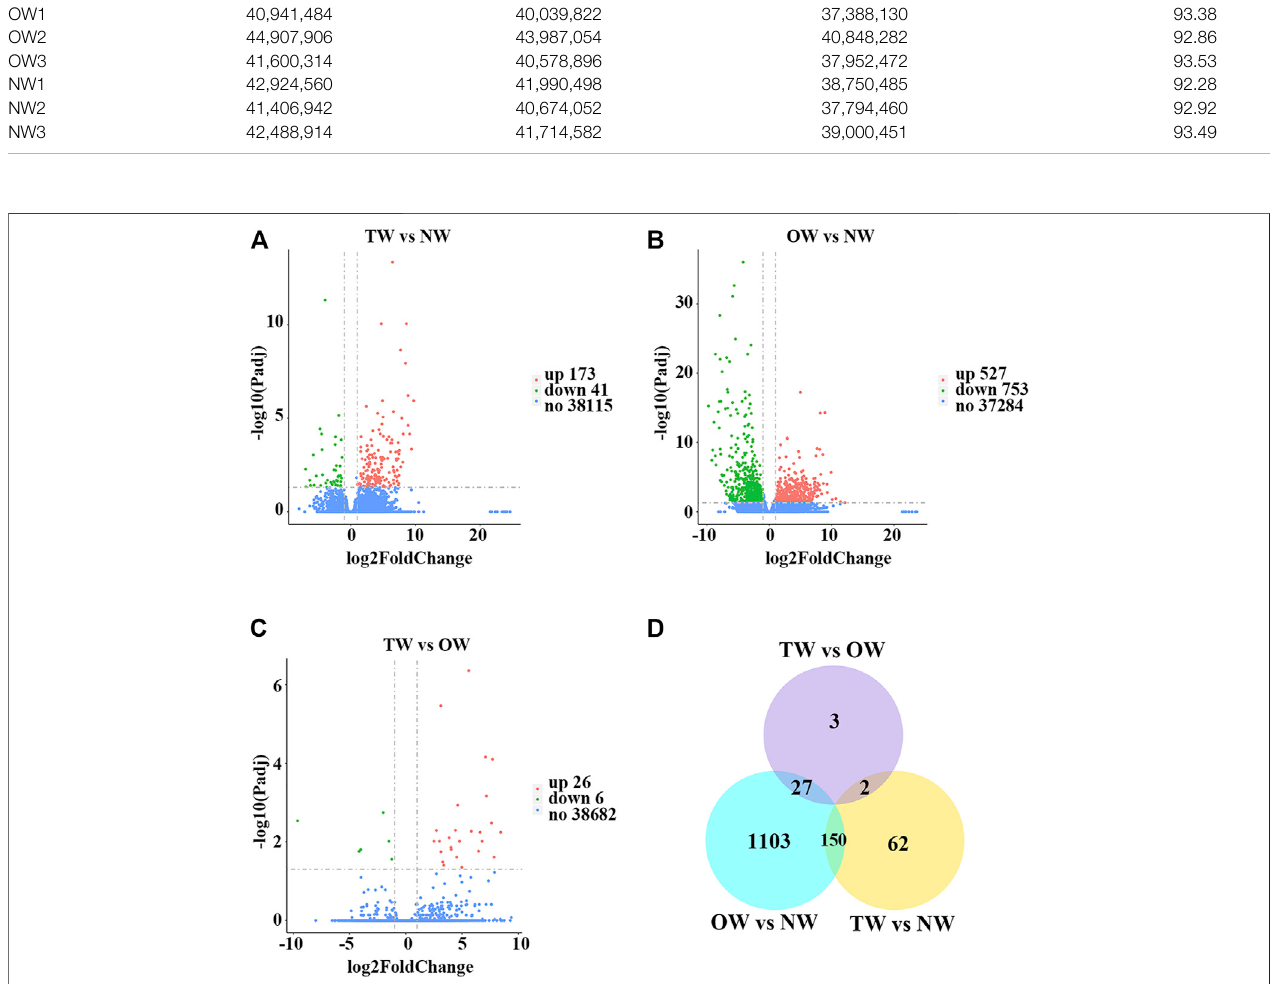
FIGURE 1 | Global analysis of gene expression in different xylem tissues of rubber tree reaction wood. Volcano plots illustrate differentially expressed genes identi fi ed in TW vs. NW (A) , OW vs. NW (B) , and TW vs. OW (C) as individual dots. Red represents up-regulation and green represents down-regulation. (D) Venn diagramshowingthetotalnumberofdifferentiallyexpressedgenesidenti fi edinTWvs.NW,OWvs.NW,andTWvs.OW,andoverlapamongthesecomparisongroups.